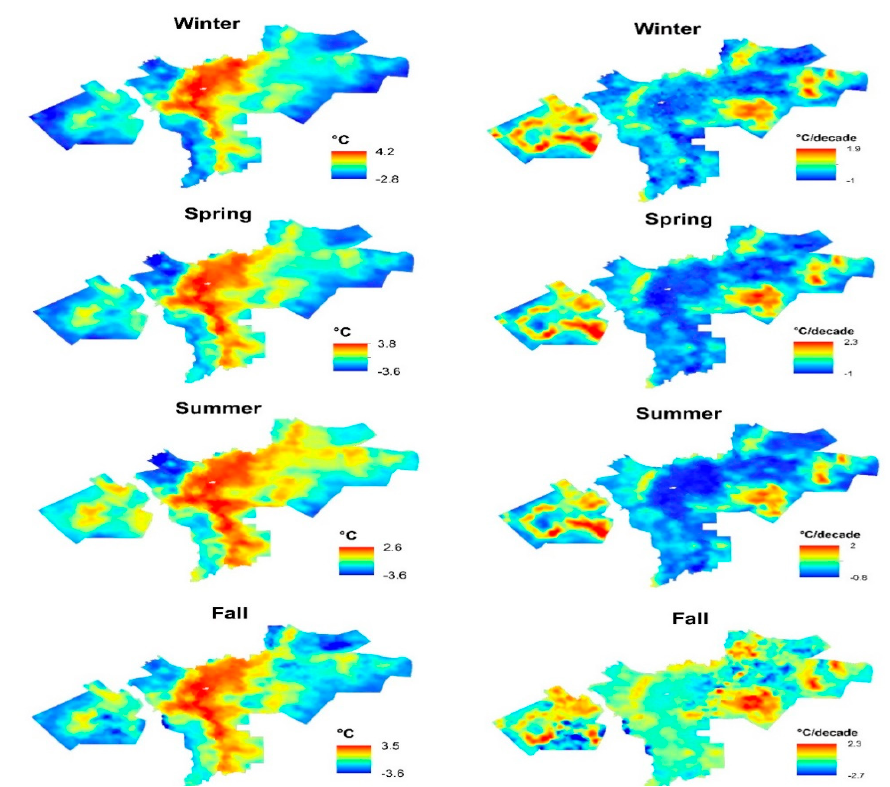
Figure 6. Left: Spatial anomaly of land surface temperature (LST) over Greater Cairo, averaged for the study period 2003–2019; right: changes (°C/decade) in LST anomalies over the period 2003–2019. Herein, changes were assessed for each season using the ordinary linear least squares regression model.